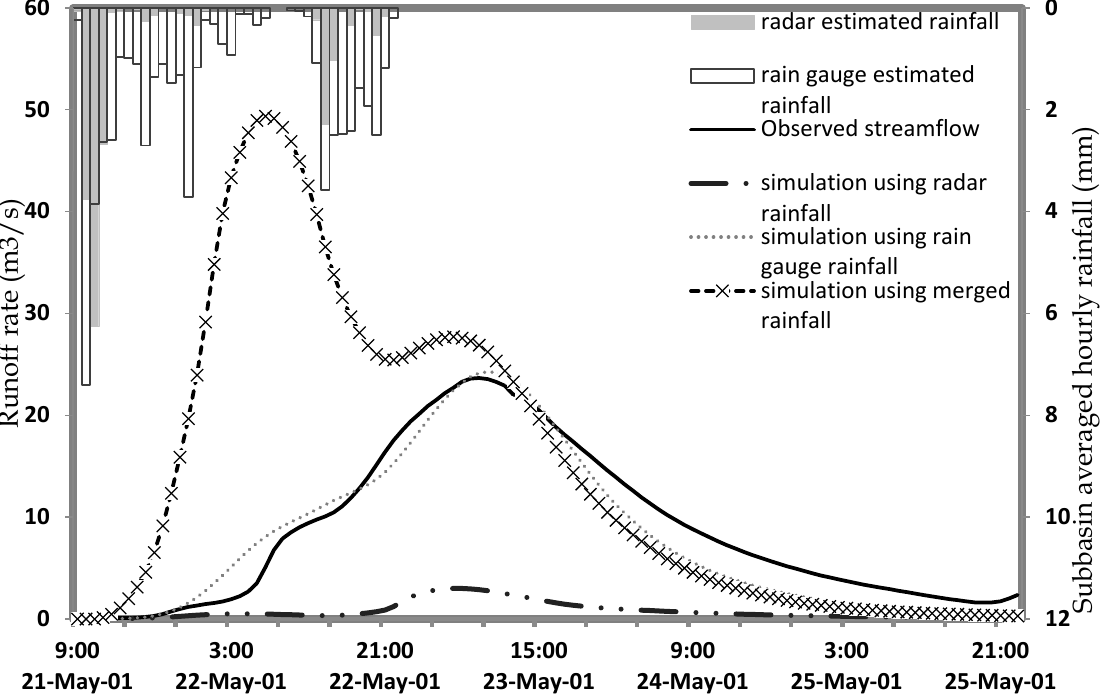
Figure 21. Comparison of estimated and observed hydrographs using different rainfall estimates for the 22 September 2000 event with Green and Ampt modeling option.